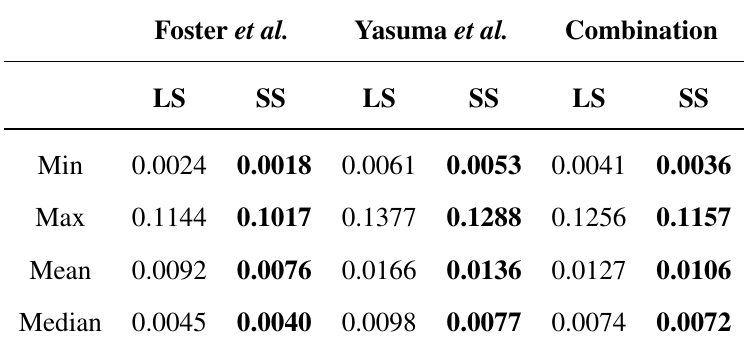
Table 7. CID results: average for 37